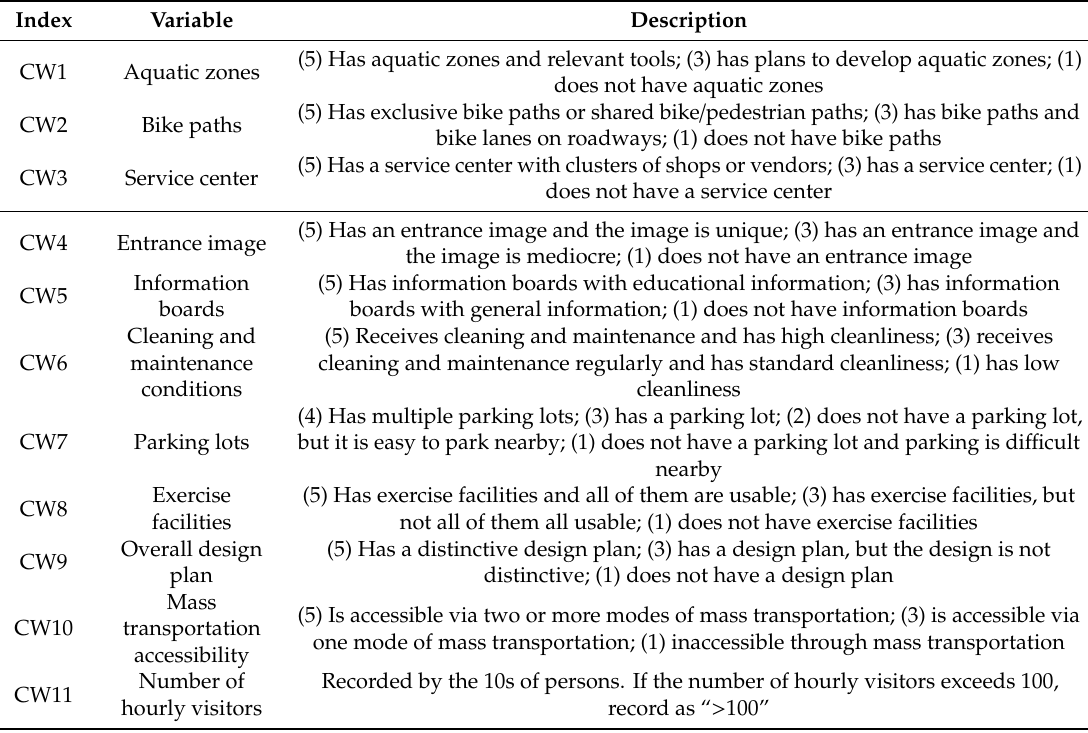
Table 3. Comfortable Water Environment Rest Assessment